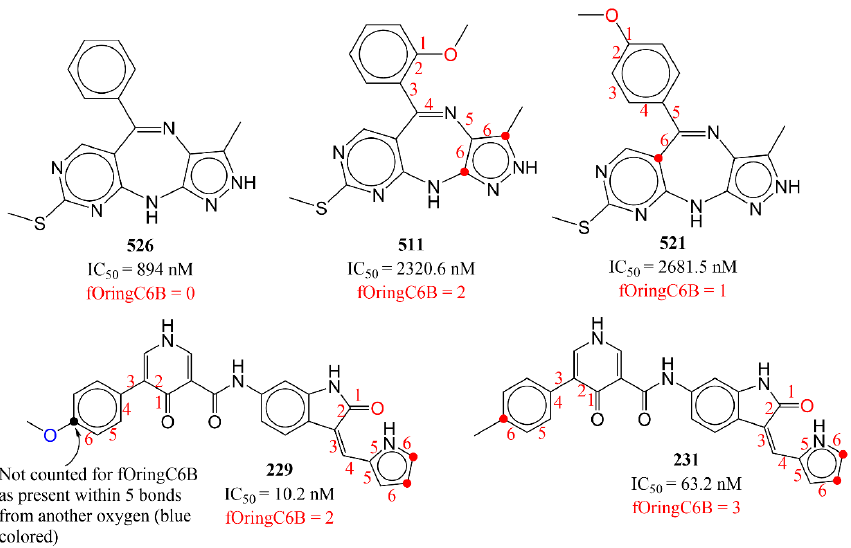
Figure 10. Representative examples for fOringC6B. The numbers (red) indicate the counting of number of bonds between ring carbon and oxygen atom. number of bonds between ring carbon and oxygen